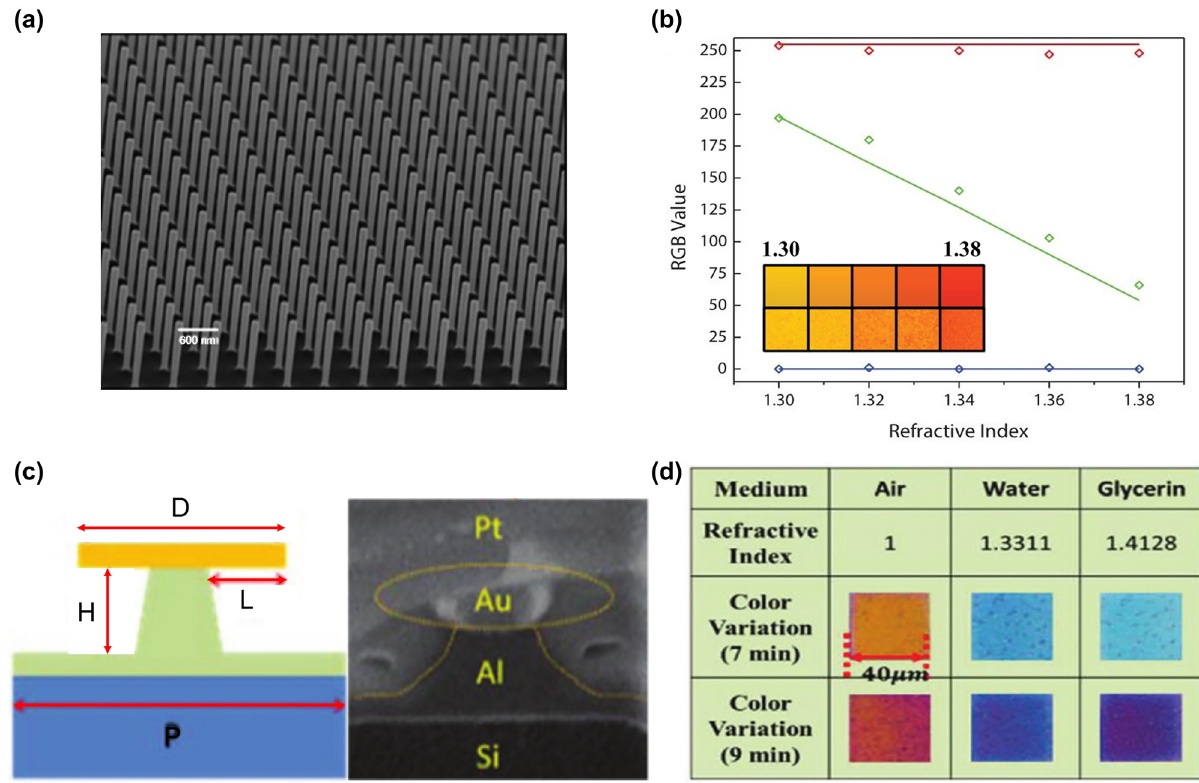
Figure 40: Colorimetric refractive index sensors. (a) SEM image of the Si nanowire array. (b) Experimentally measured (open diamonds) and theoretically predicted (solid lines) results of the displayed colors’ RGB values varying with the surrounding refractive index. Insets: the associated theoretically predicted (upper panel) and experimentally observed (lower panel) colors. Modified with permission [352]. Copyright 2014, Wiley-VCH. (c) Schematic (left panel) and SEM image (right panel) of the three-layer stacked structure consisting of an Au disk, an Al pillar, and a planar Al reflector. (d) Colorimetric responses of two sensors in air, water, and glycerin (60%), respectively. The color of the sensor with a 7 min etching time (the cavities have not formed yet) transits from yellow to blue and then light blue for different surrounding media, while the color change of the sensor with a 9 min etching time (the cavities have formed) is more noticeable (red–blue–violet). Modified with permission [353]. Copyright 2020, Royal Society of